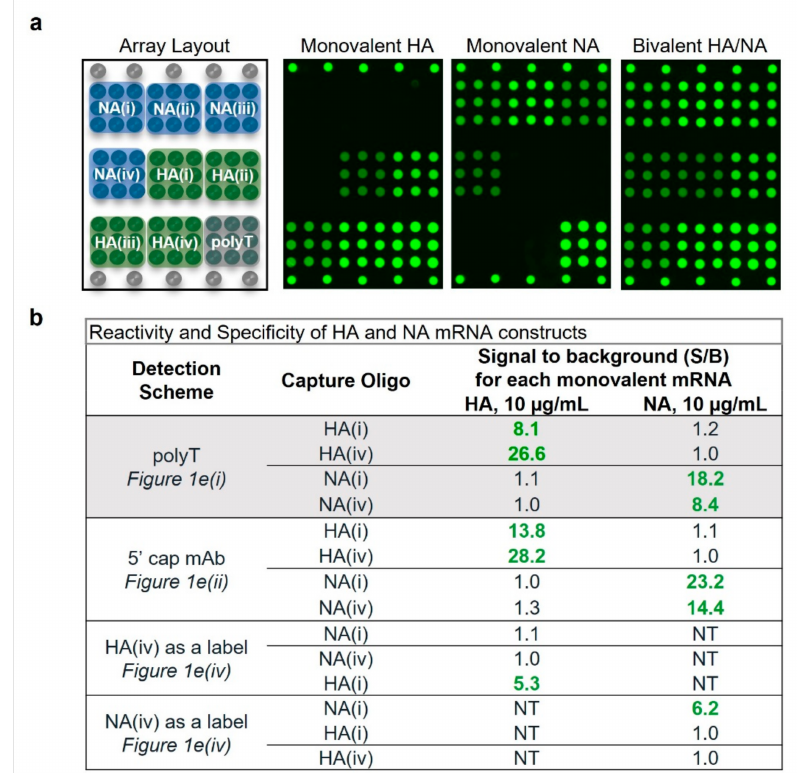
Figure 2. Naked mRNA reactivity and specificity. ( a ) Representative microarray images demonstrat- ing reactivity and specificity of 10 µ g/mL mRNA using the polyT label. ( b ) Signal/background (S/B) for monovalent HA and NA for four different labeling schemes (average of n = 3 for each value). Text in bold green shows S/B > 3 generated, which indicates positive signal. NT indicates not